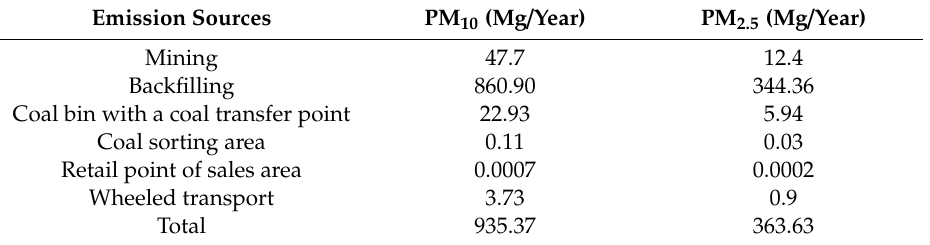
Table 3. PM 10 and PM 2.5 emission from ELT in 2018 by sector (on the basis of